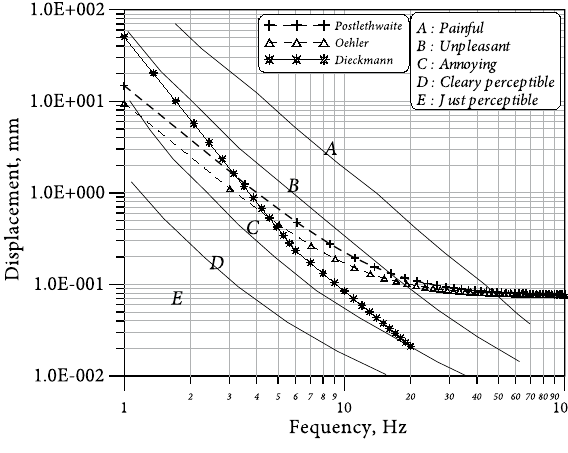
Fig. 1. Comparison with other vibration